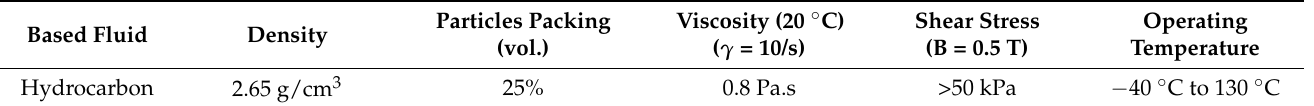
Table 1. Specifications of the MRF.